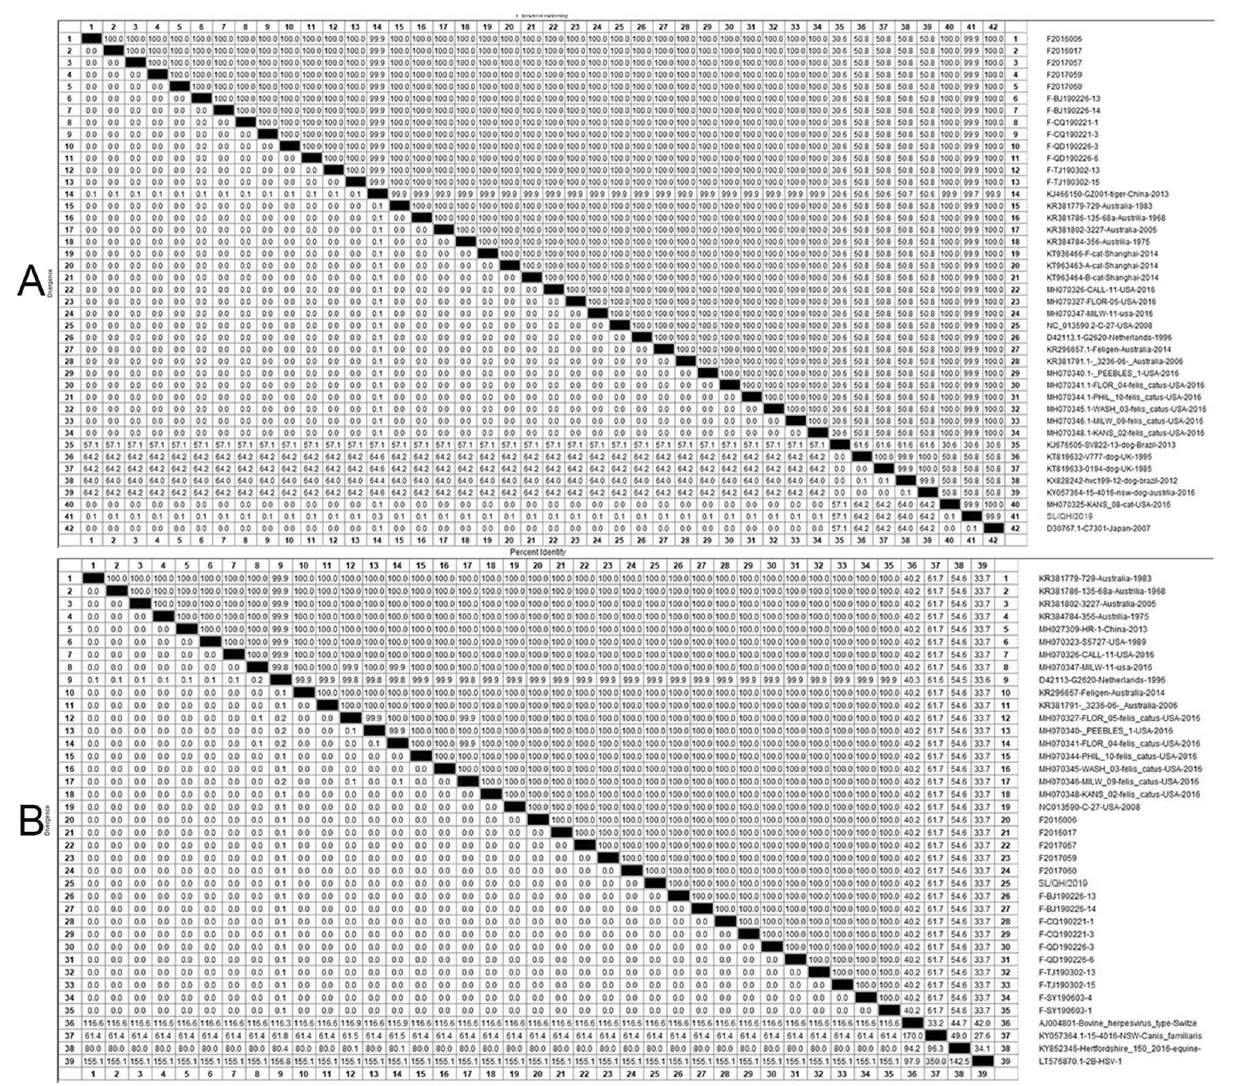
Figure 6. Alignment of the nucleotide sequences of FHV-1 gene. ( A ) Alignment of the gD gene of FHV-1. SL/ QH/2019 share 99.9% identity with isolates of FHV-1 from cats and 99.7% identity with isolates of FHV-1 from tigers in China on the gD gene. While SL/QH/2019 share low identity (from 30.6 to 50.8%) with CHV-1 on the gD gene. ( B ) Alignment of the gE gene of FHV-1. SL/QH/2019 share 100% identity with isolates of FHV-1 from cats; however, low identity (from 27.6 to 61.7%) with CHV-1 on gE gene. ▲ : The mainly epidemic isolates in